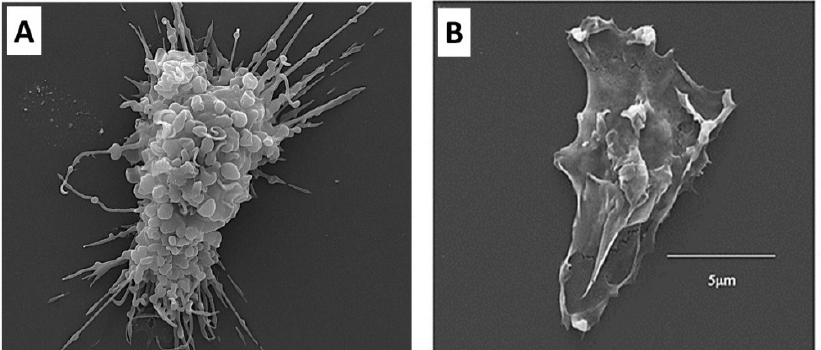
Figure 4. Scanning electron microscopy (SEM) of macrophages. ( A ) An adherent macrophage lacking α -gal epitopes and incubated with α -gal nanoparticles coated with the anti-Gal antibody, then washed and processed for SEM. Note the multiple α -gal nanoparticles binding to the macrophage via Fc/Fc receptor interactions and covering the surface of the macrophage. ( B ) A macrophage incubated with α -gal nanoparticles in the absence of anti-Gal. No nanoparticles bind to the macrophage cell membrane in the absence of the antibody. Adapted with permission from ref. [57].